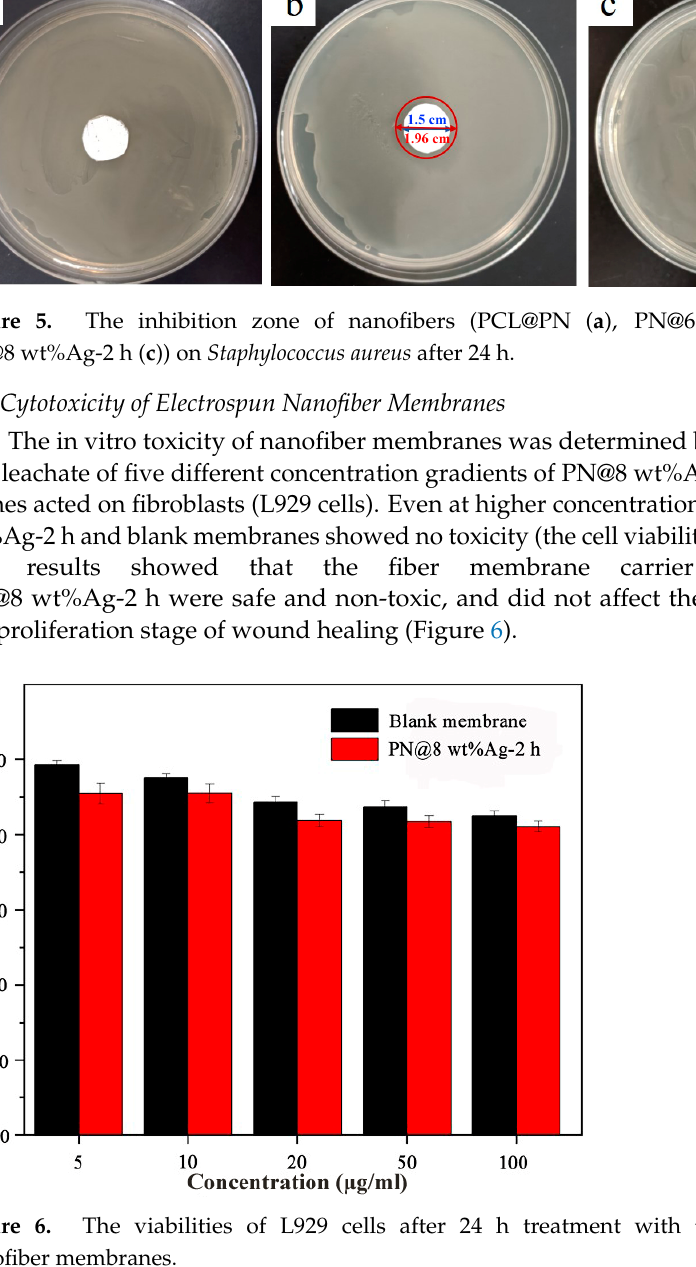
Figure 6. The viabilities of L929 cells after 24 h treatment with the PN@8 wt%Ag-2 h nano fi ber mem- branes.